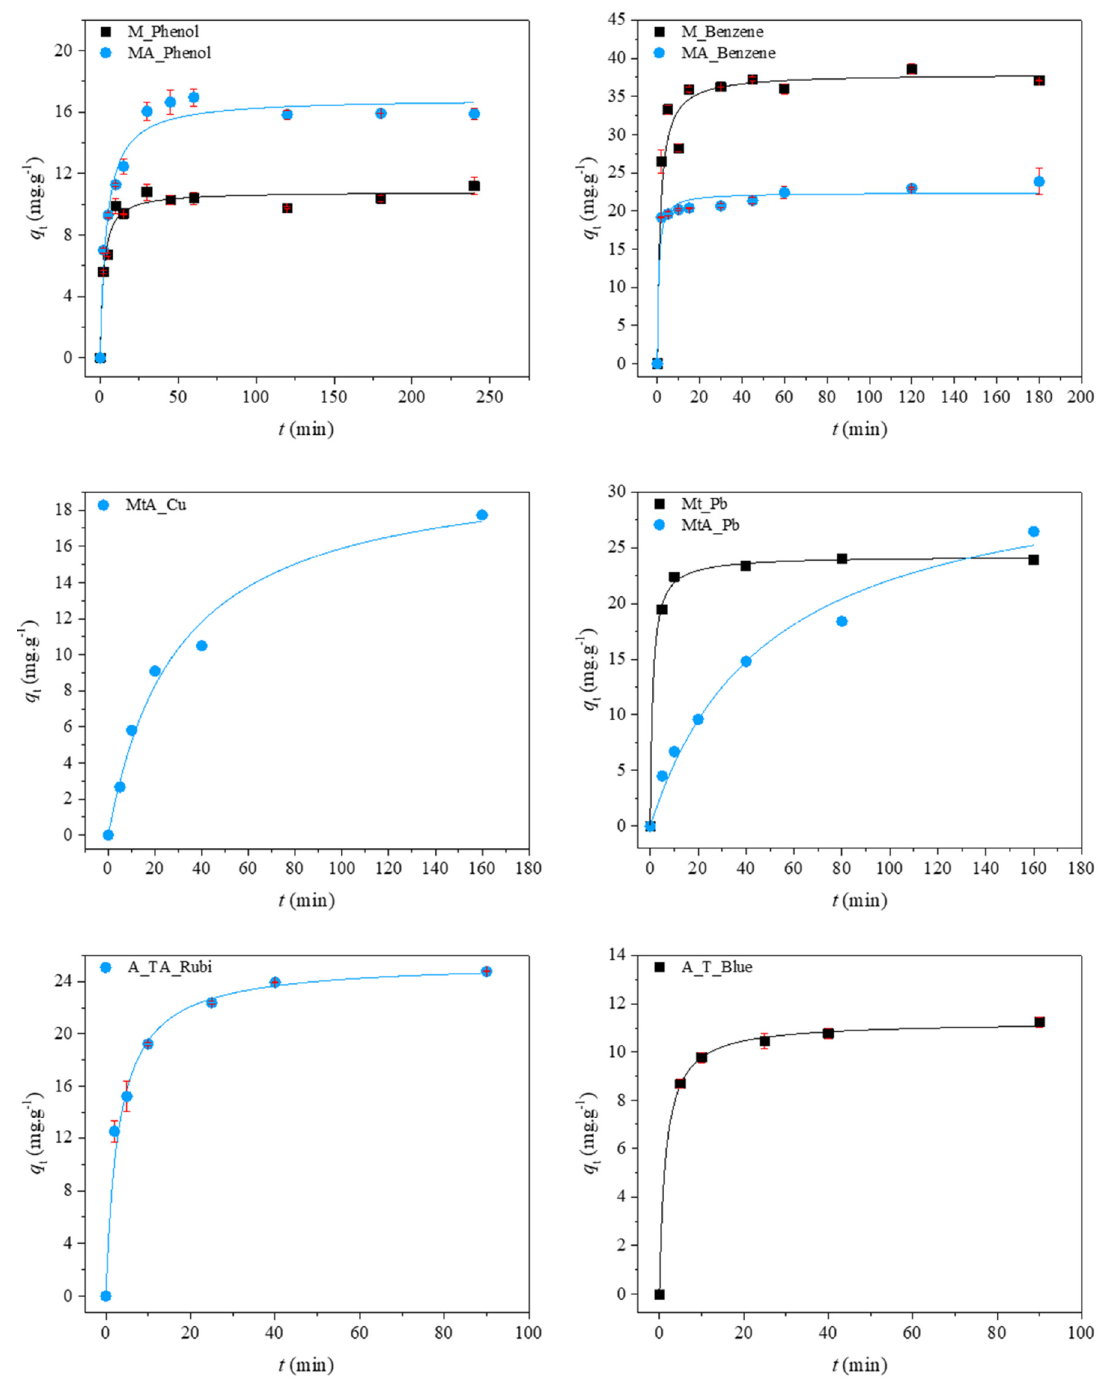
Figure 3. Representative plots of the fit of non-linearized form of pseudo-second order equation (solid line) to the data of experimental adsorption capacity as function of time, for the studied adsorbents towards VOCs ( C 0 = 100 ppm, 15 rpm, 20 ◦ C), heavy metals ( C 0 = 200 ppm, 15 rpm, 20 ◦ C) and dyes ( C 0 = 50 ppm, 15 rpm, 20 ◦ C) in aqueous solution.